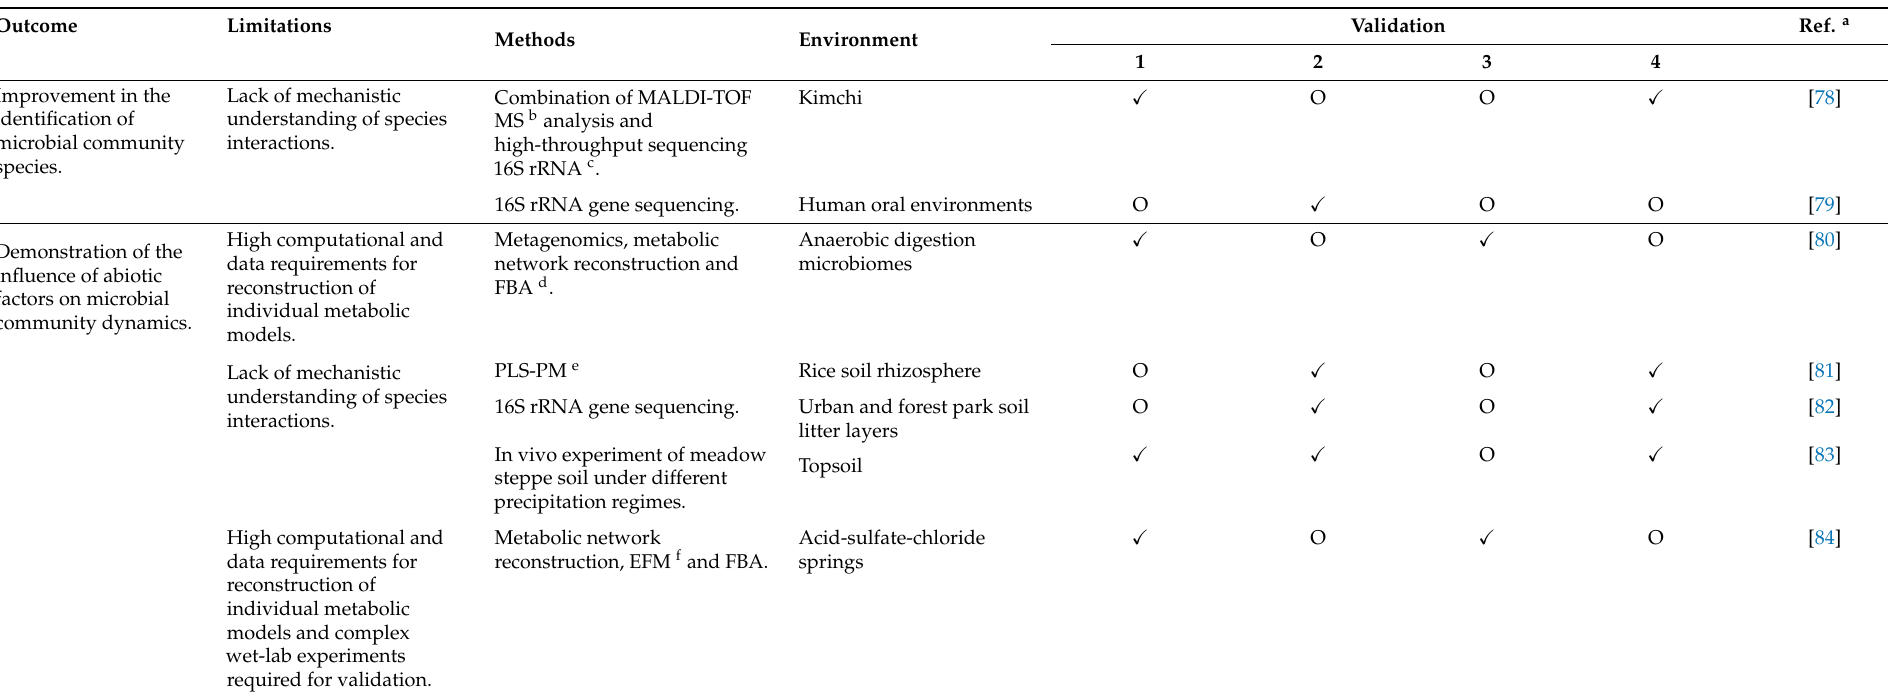
Table 2. Outcomes and limitations of different methods to study microbial interactions. We assigned four validation strategies to confirm microbial interaction as following: (1) Expression or activity assays (e.g., transcriptomics, proteomics, metabolomics, RT-PCR, FBA); (2) 3D structure and spatial variability; (3) Substrate specificity; and, (4) Temporal variability. Outcome Improvement in the identification of microbial community